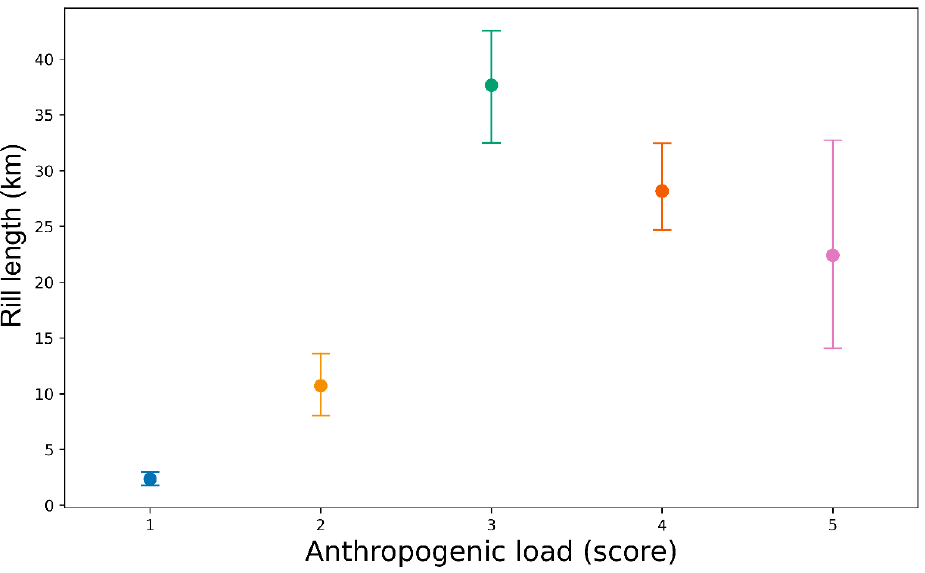
Figure 20. The dependence of the length of the rill erosion network on the anthropogenic load. The intensity of erosion processes increases with increasing anthropogenic load, but not linearly. The maximum intensity of erosion is observed under moderate anthropo ‐ genic load. Decrease of the total length of erosion forms with further increase of anthro ‐ pogenic load is related to decrease of the area not occupied by cities, manufactories, and other anthropogenic objects. The cumulative effect of anthropogenic load, forest cover, prevailing soil type, and soil ‐ forming rocks has the most significant contribution to the development of erosion processes in the study area (Figure 21). Figure 21. QQ–plot of MANOVA between rill network and forest cover, anthropogenic load, pre ‐ vailing soil type, and soil ‐ forming rocks.